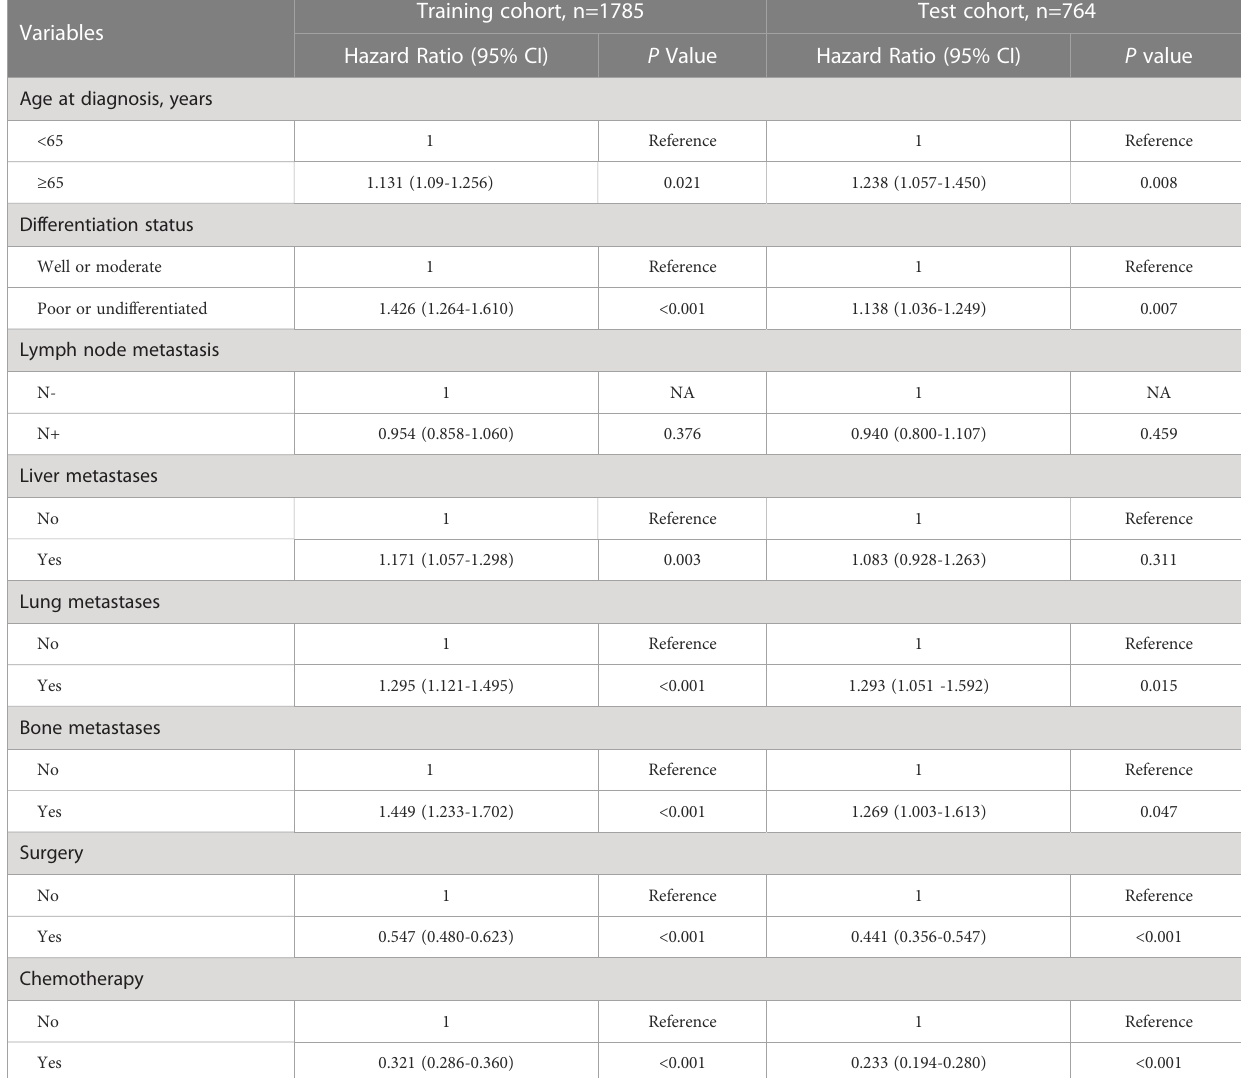
TABLE 2 Multivariable analysis for overall survival of gastric cancer patients with distant metastases at fi rst